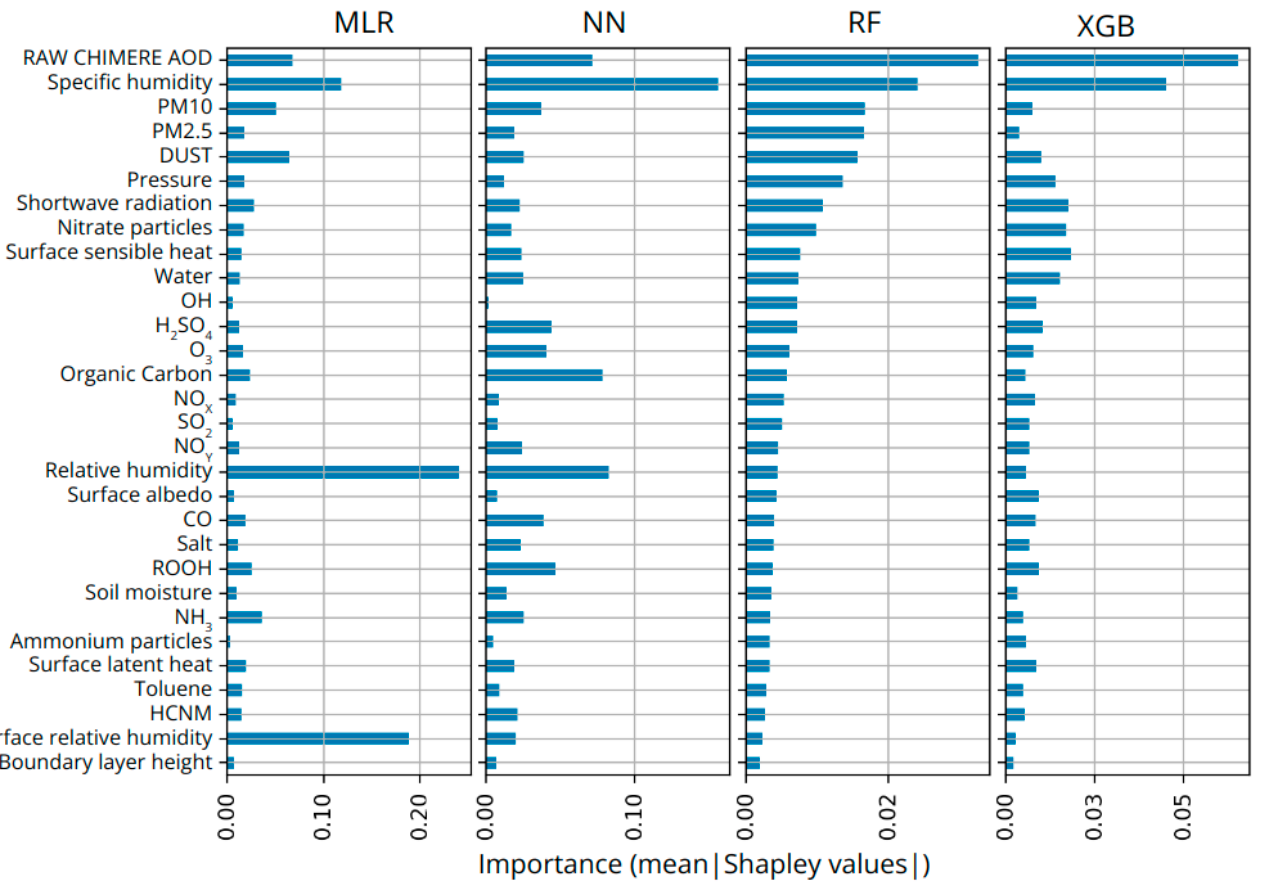
Figure 5. Mean absolute Shapley values for the input variables of the ML models for the 30 September 2021.